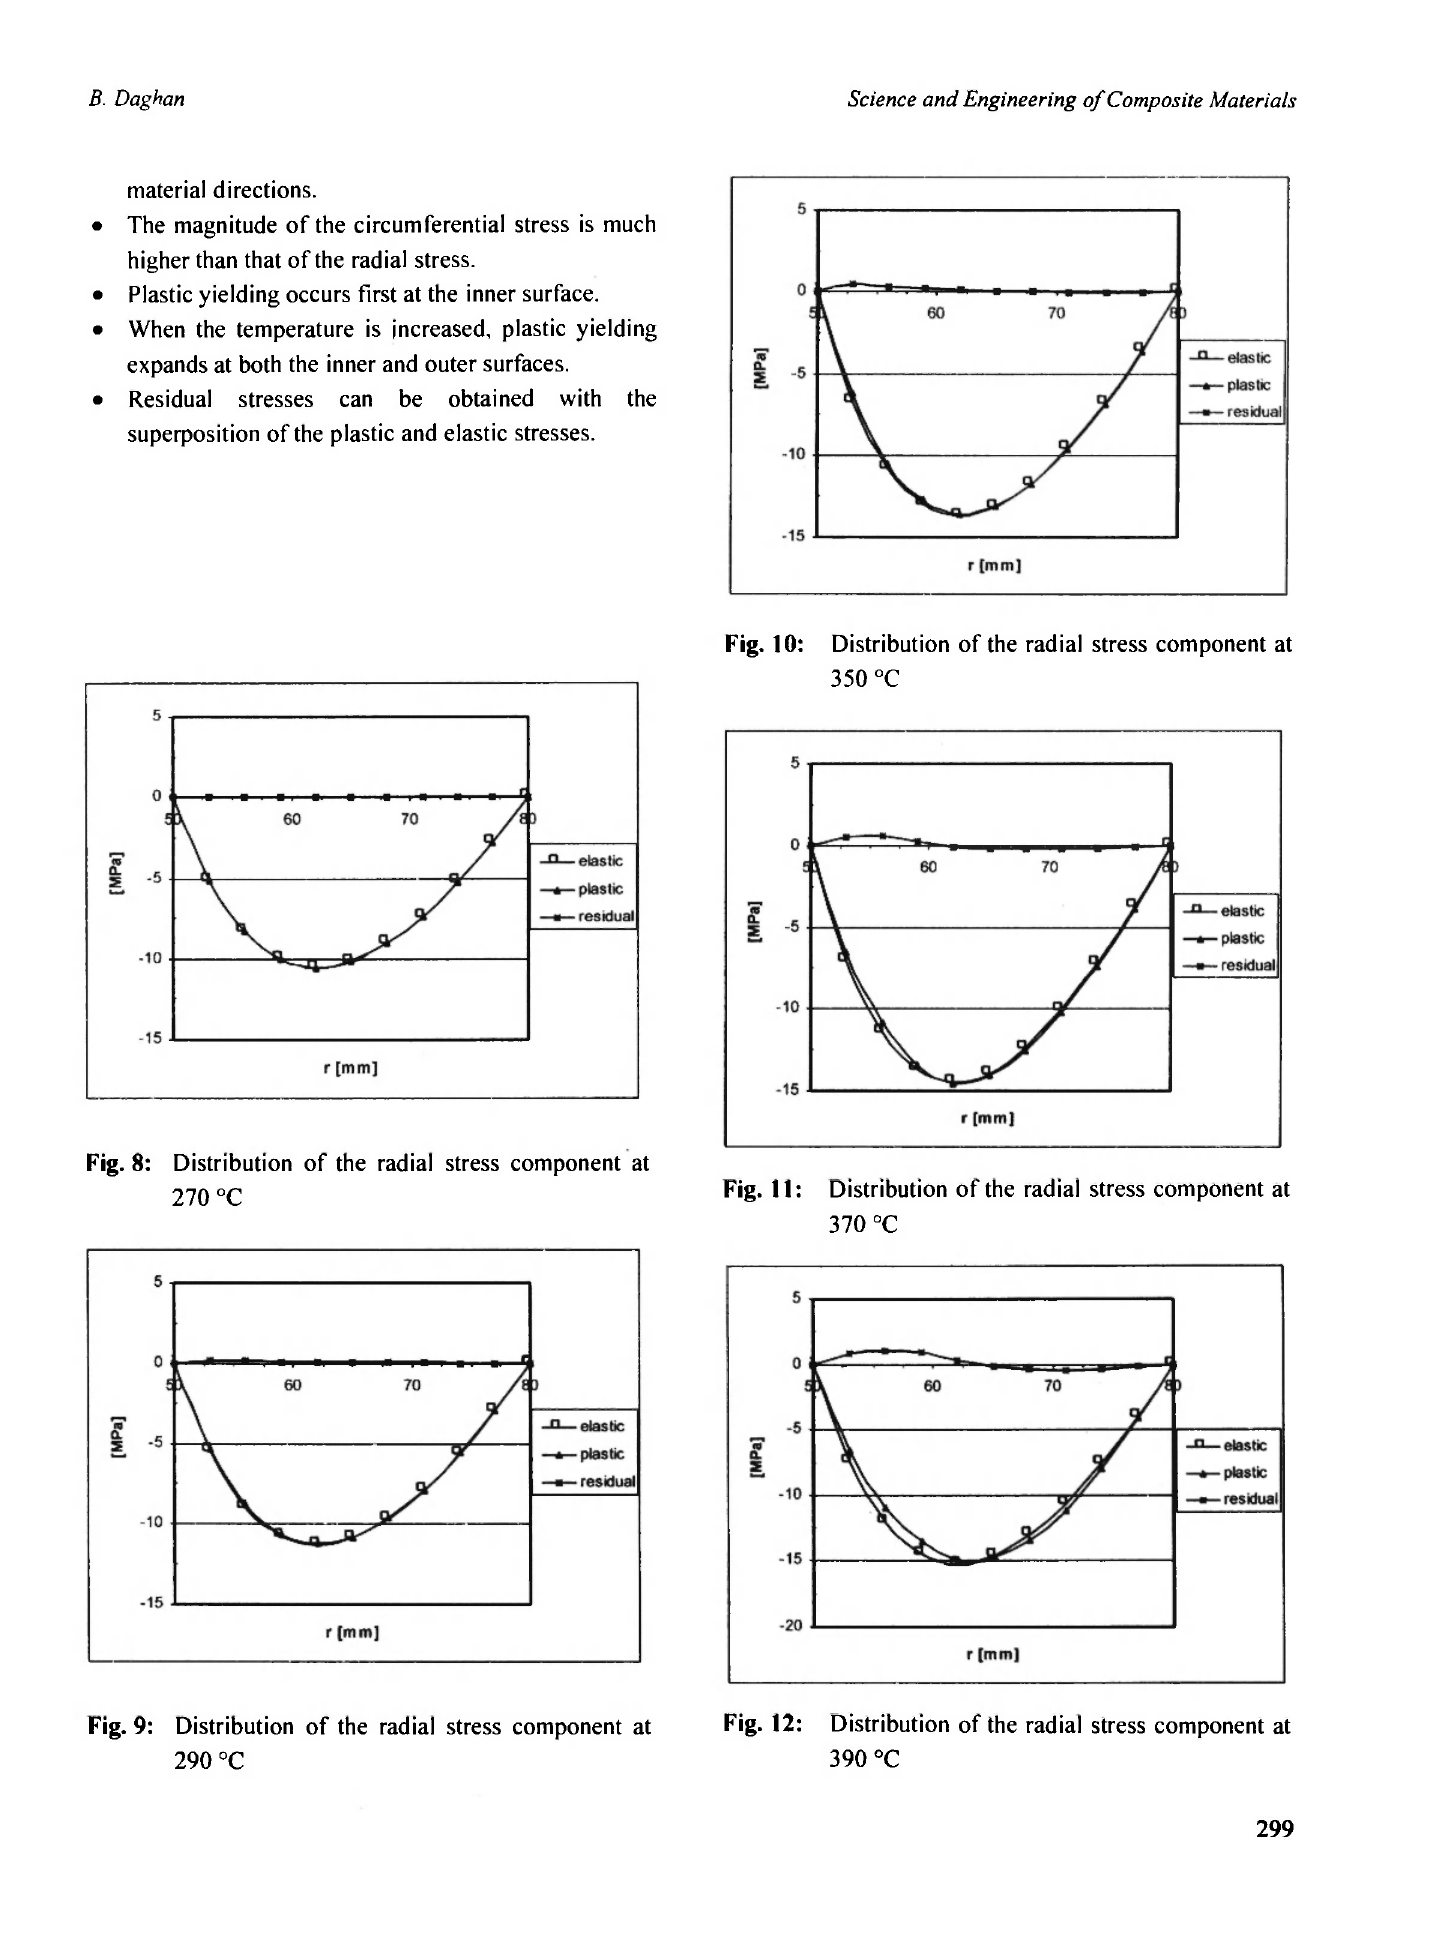
Fig. 9: Distribution of the radial stress component at 290 °C